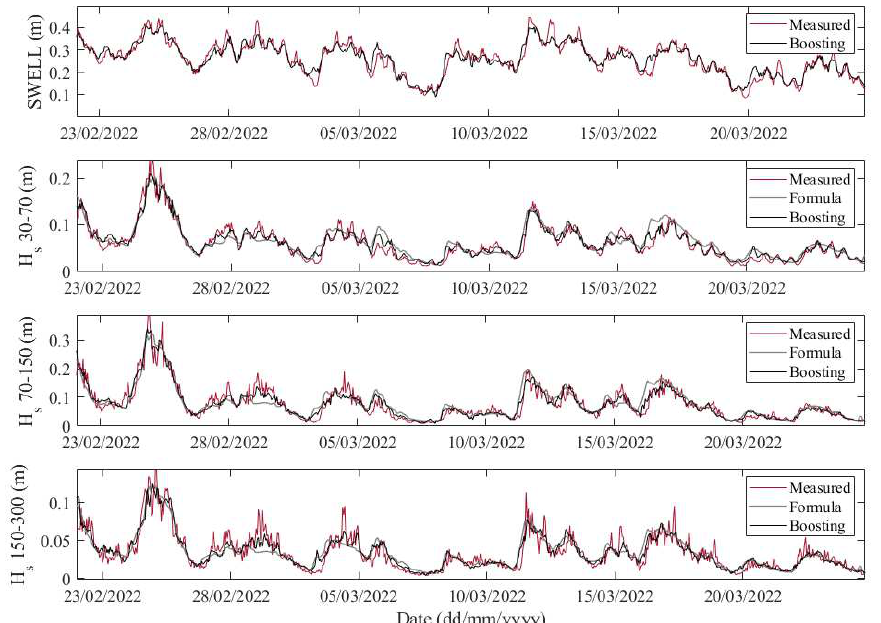
Figure 4. Measured data (maroon) and forecast data with the formula (grey) and with GBM (black) of the H s at the tide gauge for the different frequency ranges.